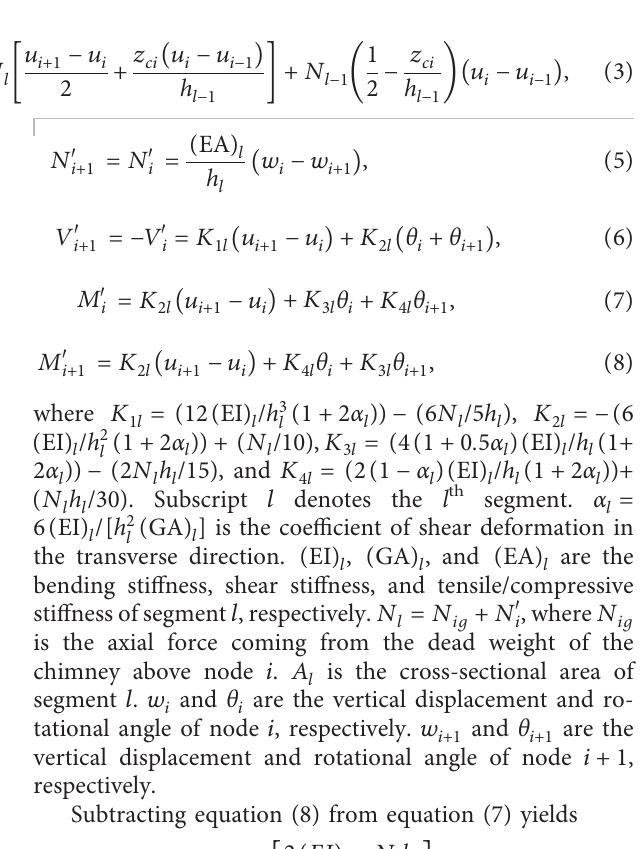
Figure 3: Free-body diagrams of segment l .